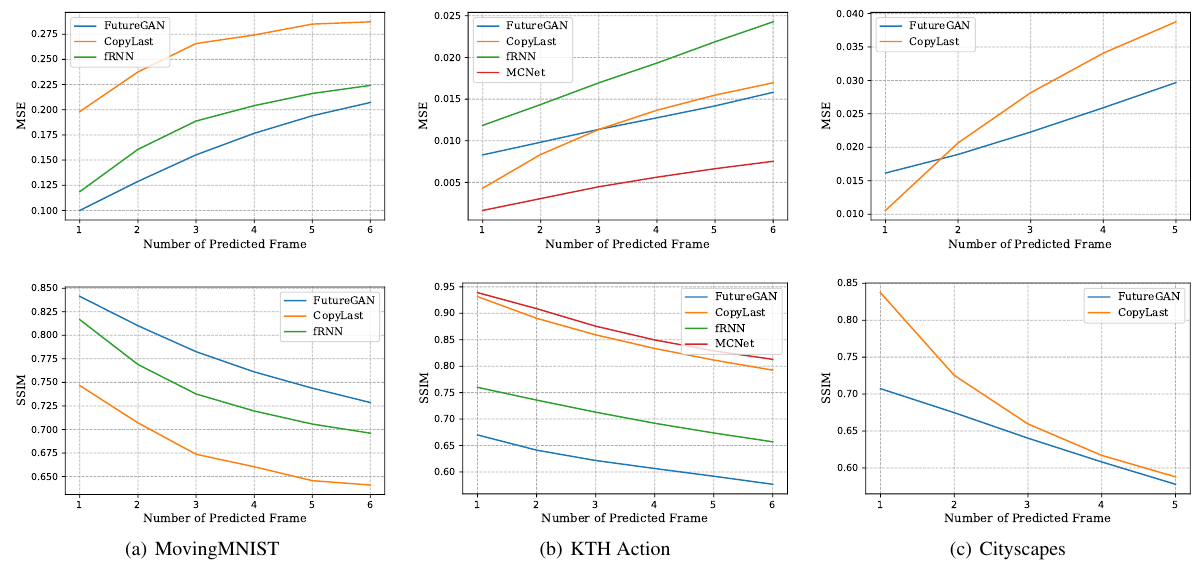
Figure 3. Quantitative results per predicted frame. Table 1. Average results over 6 frames (best results are bold)